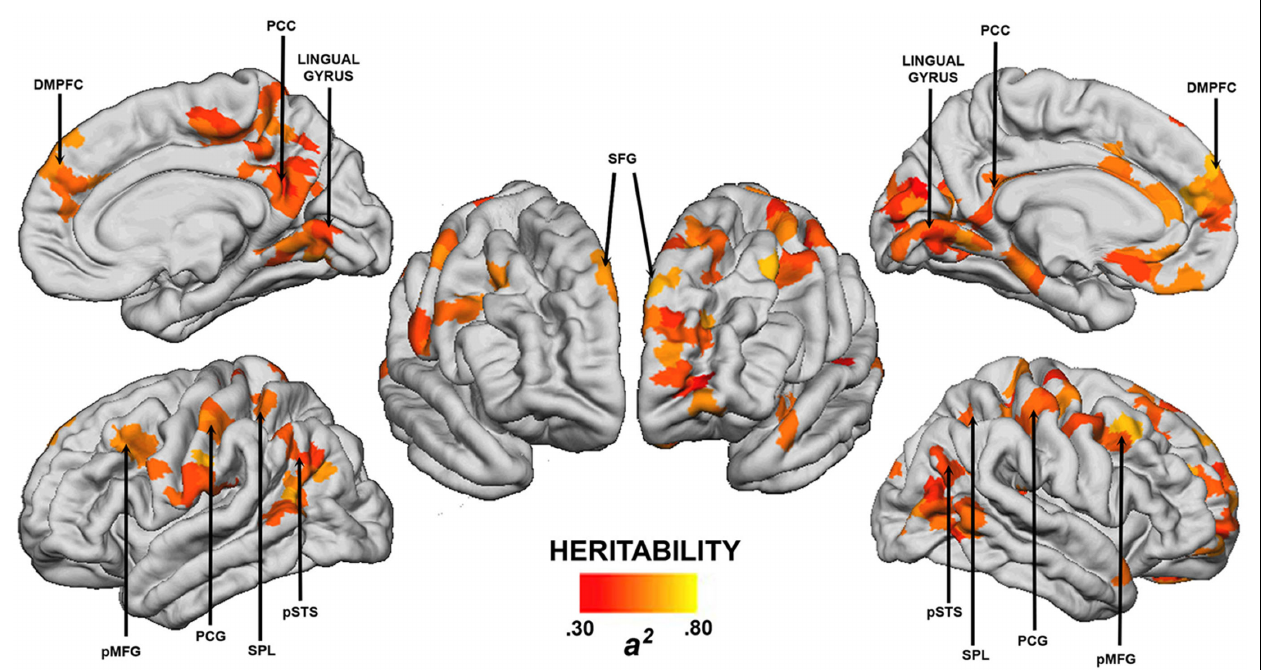
posterior cingulate cortex; SFG, superior frontal gyrus; pMFG, posterior middle frontal gyrus; PCG, post-central gyrus; SPL, superior parietal lobule; pSTS, posterior superior temporal sulcus. Left hemisphere is presented on the right. Image reproduced from Fornito et al. (2011b).